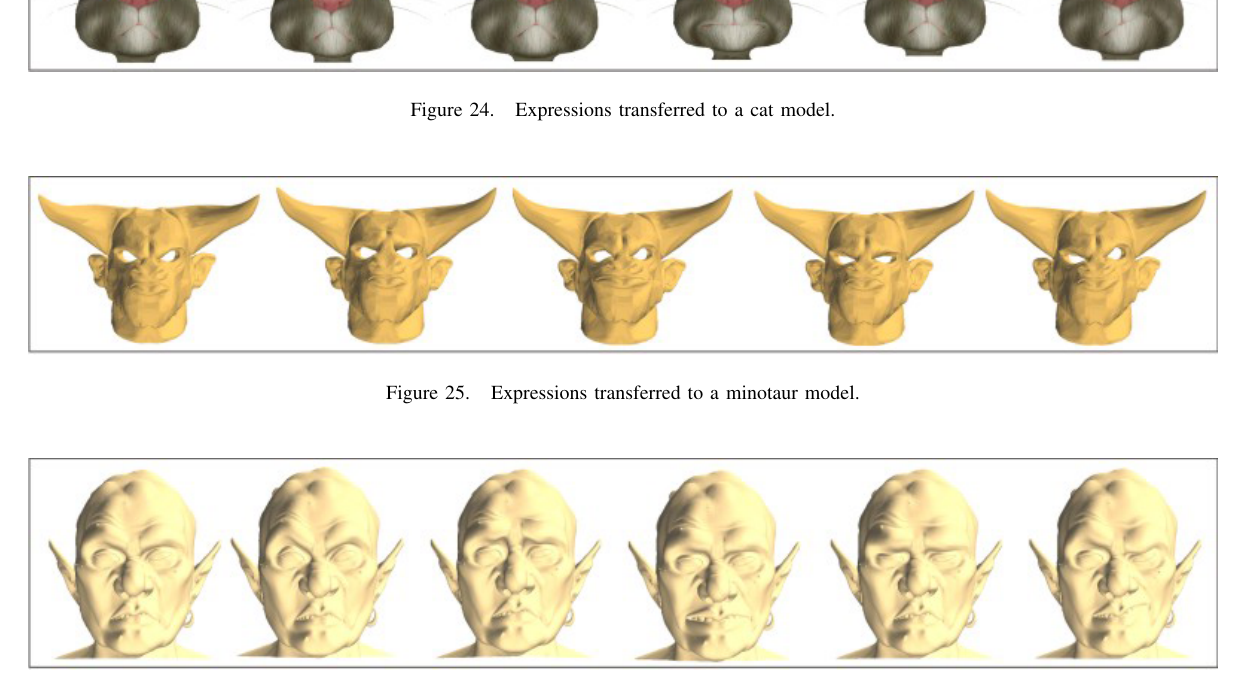
Figure 26. Expressions transferred to an ogre